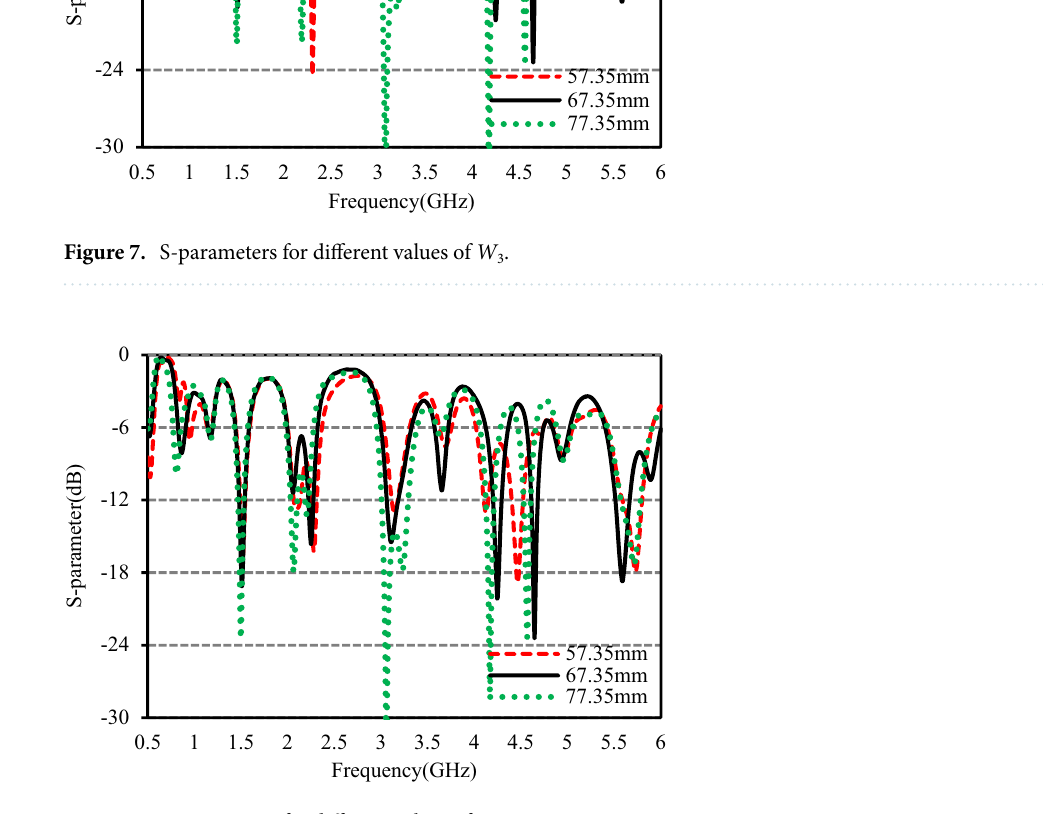
Figure 8. S-parameters for different values of W 6